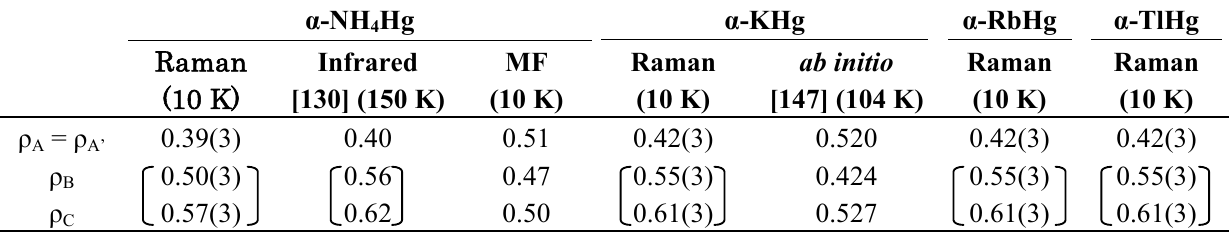
Table 4. Site hole numbers of α -(BEDT-TTF) denotes mean-field